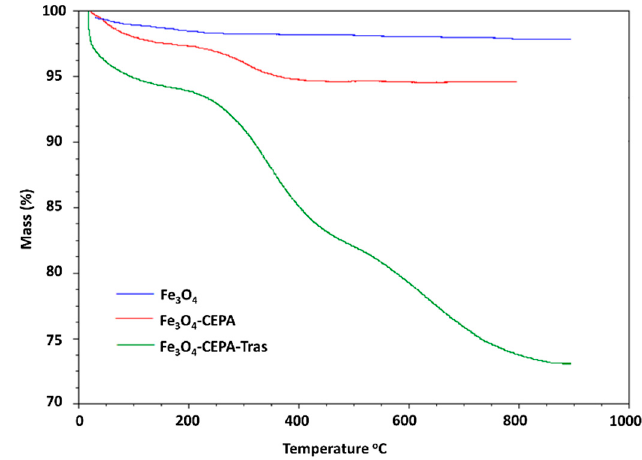
Figure 4. Representative thermograms of bare Fe 3 O 4 nanoparticles and functionalized with CEPA and trastuzumab molecules.